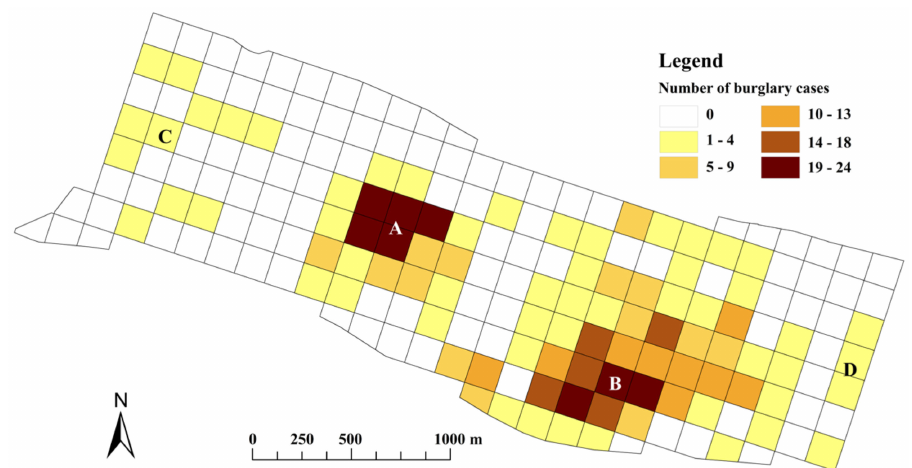
Figure 3. Distribution map of burglary cases (A, B, C, and D indicate hotspots; N = 192 sample grid cells).